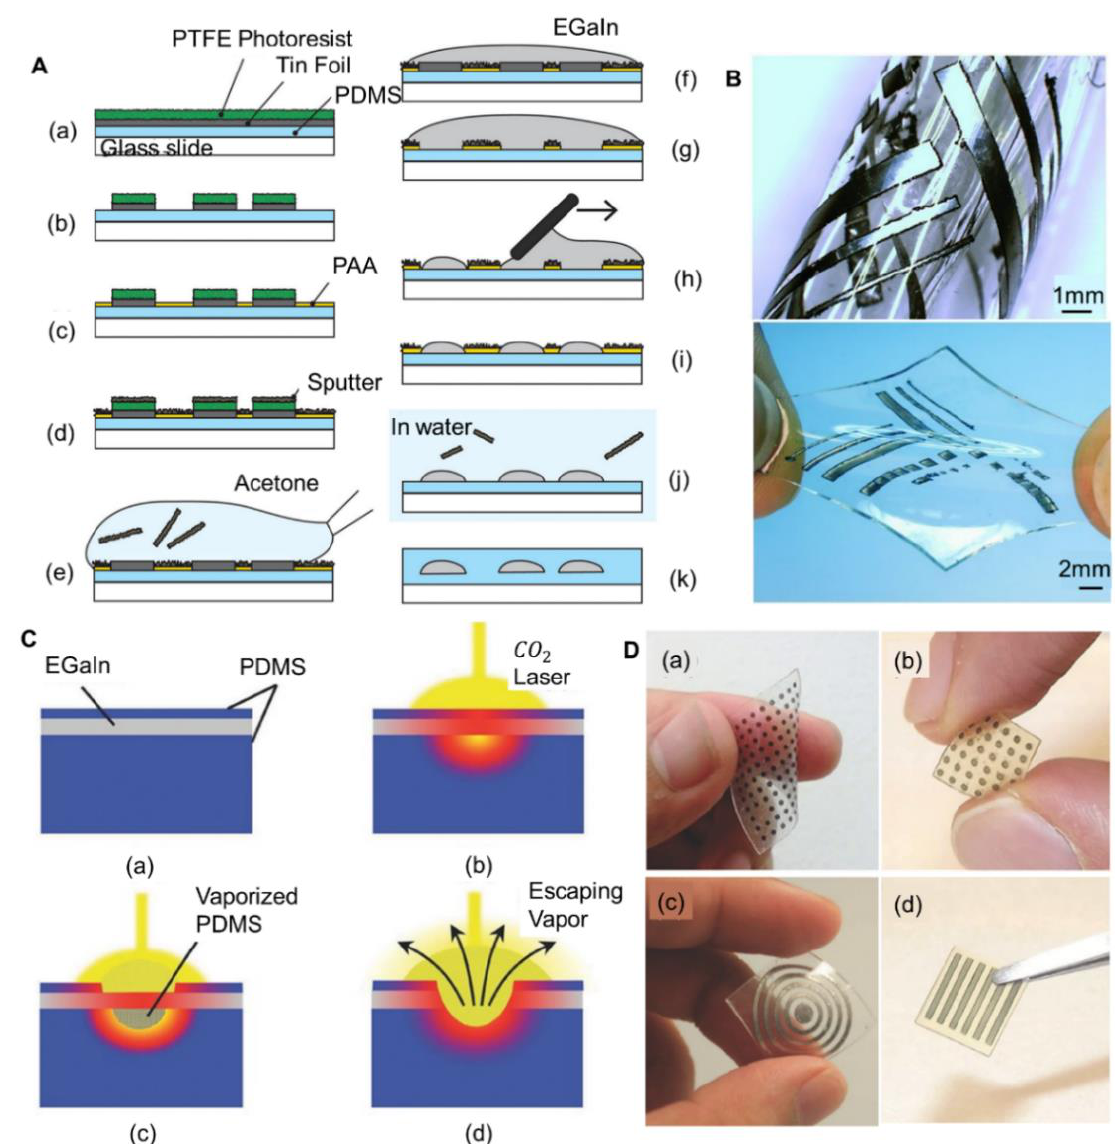
Figure 4. Diverse techniques to fabricate liquid-metal soft electronics. ( A ) Fabrication process of selective liquid metal deposition: ( a ) Photoetching; ( b ) Photoresist developing; ( c ) Spinning poly acrylic acid (PAA); ( d ) Sputtering the surface with indium; ( e ) Removing photoresist; ( f , g ) Flooding the surface with liquid metal; ( h , i ) Removing excess liquid metal; ( j ) Removing indium mask; ( k ) Encapsulating the circuit. Reproduced with permission from [100]. ( B ) A circuit embedded in elastomer patterned by selective deposition of liquid metal, reproduced with permission from [100]. ( C ) Illustration of CO 2 laser engraving technology, reproduced with permission from [102]. ( D ) Flexible circuits fabricated by CO 2 laser, reproduced with permission from [102].